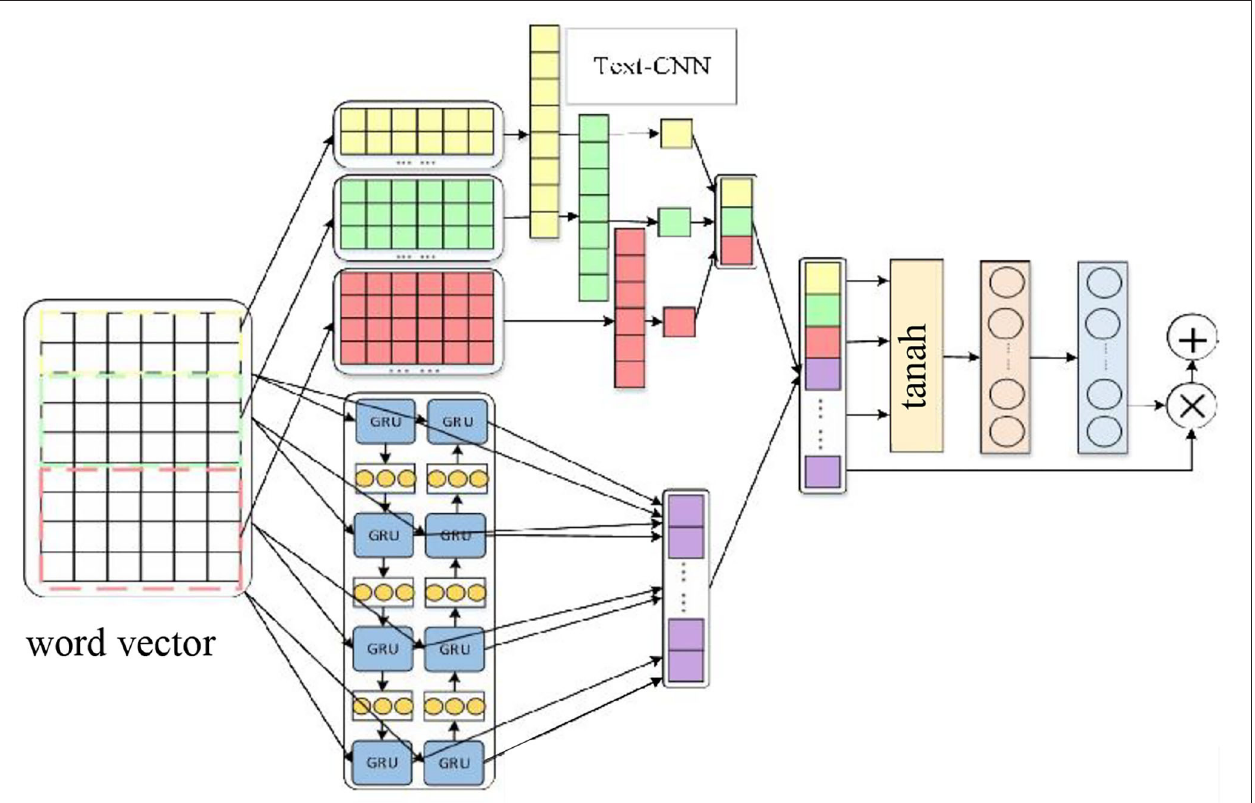
FIGURE 3 | Model based on the parallel hybrid network integrating the attention